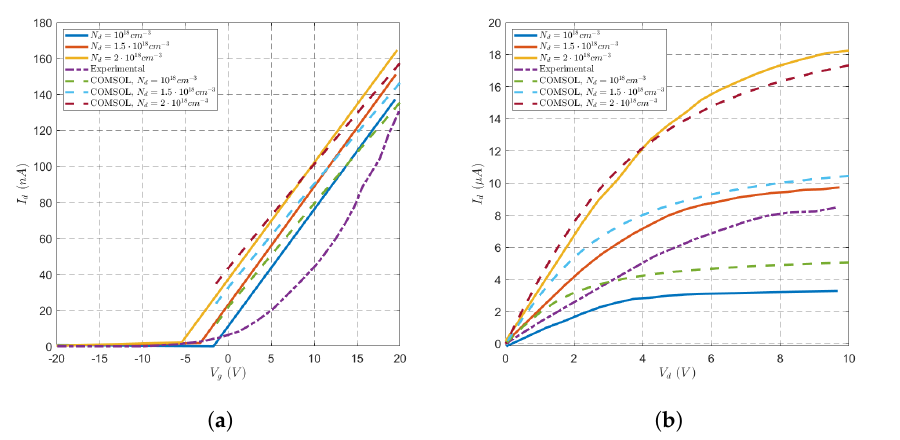
Figure 8. I-V curves for 4-layer MoS 2 . Transfer characteristic for different doping concentration and V ds = 0.01 V ( a ), output characteristic for V gs = 10 V ( b